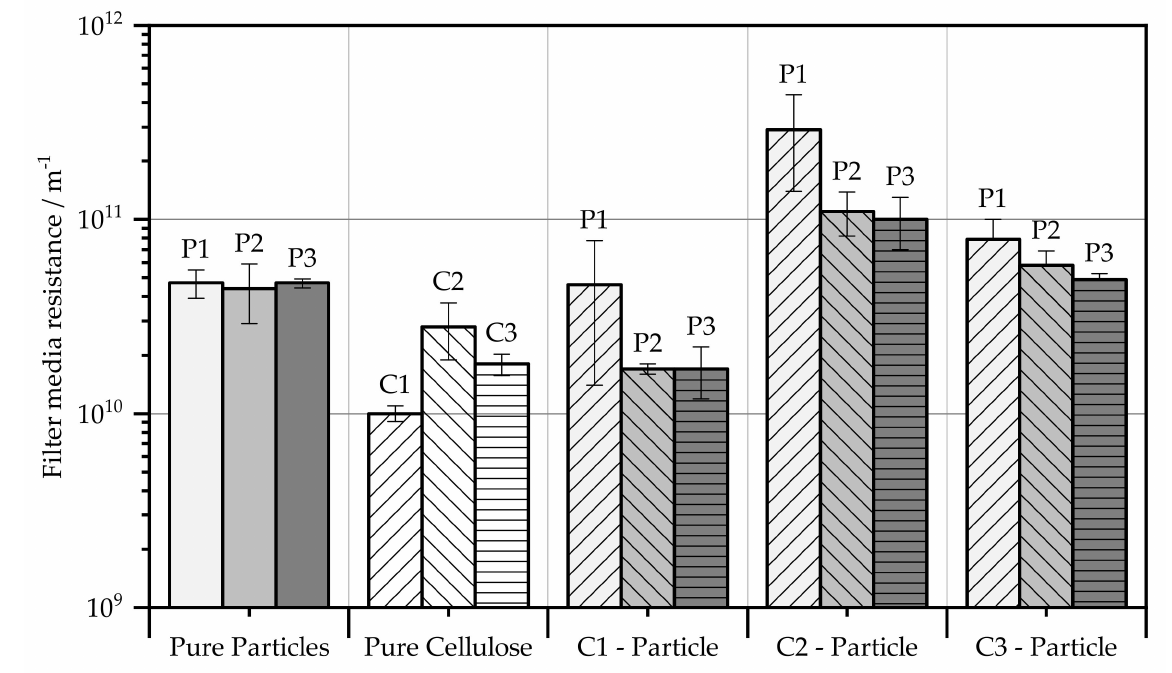
Figure 4. Filter media resistances of the pure filter aids, particle systems, and their combinations.